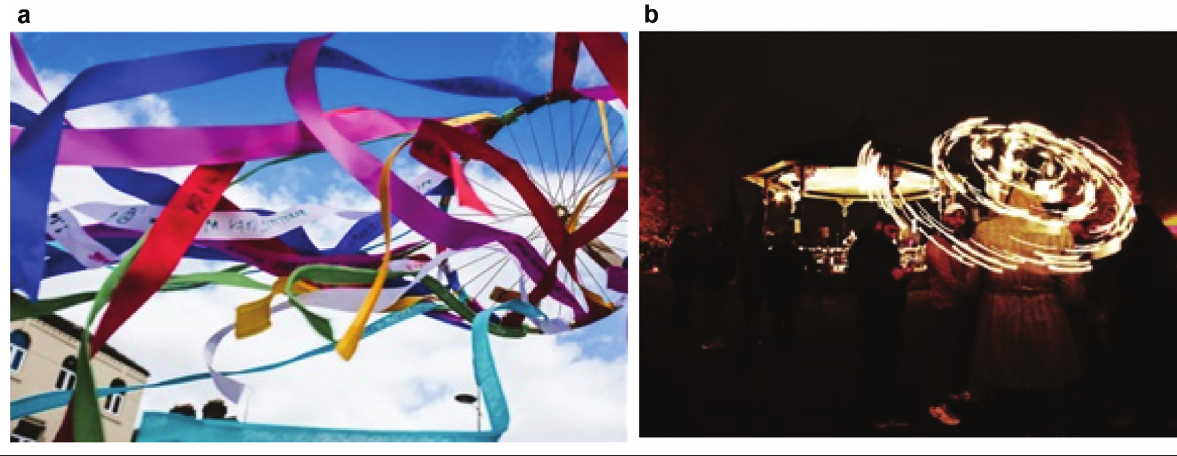
Figure 4. Artists’ creative consultation tools (Source: intervention by Nicola Winstanley and Sarah Nadin; photographs by Jenny Harper, 2015). (a) Ribbon wheel; (b) Firegarden light